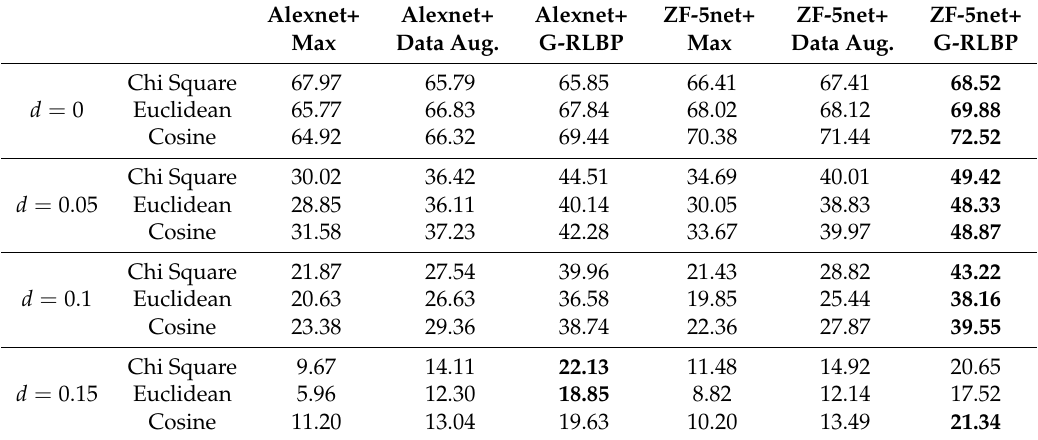
Table 7. The recognition rates (%) of different pooling methods and data augmentation based on the Alexnet and ZF-5net on the AR database with different salt and pepper noise.